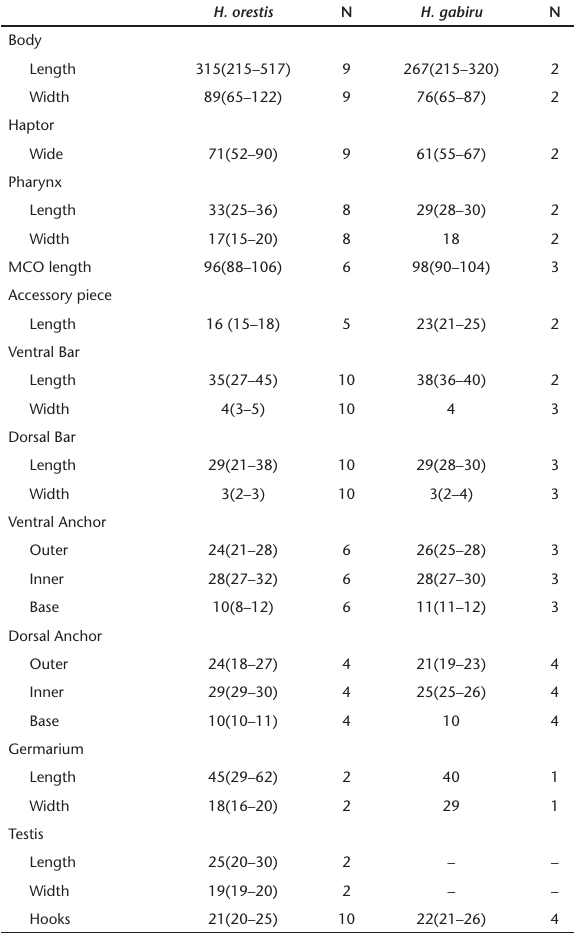
Table 7. Comparative measurements (μm) of specimens of Van- cleaveus klasseni sp. nov. from the gills of Hassar orestis and H. gabiru from Xingu River